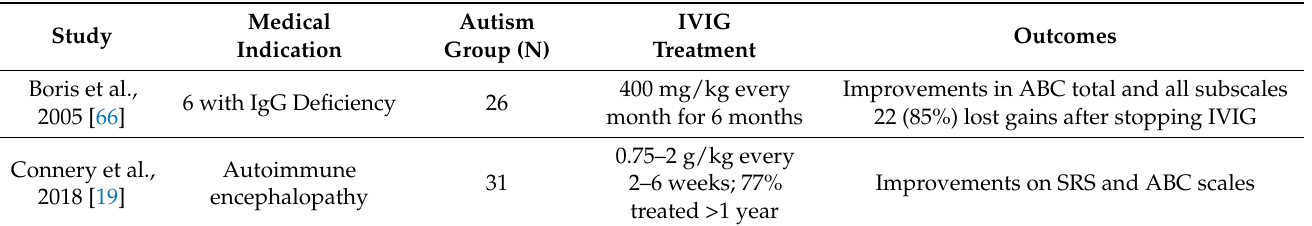
Table 5. Retrospective Case Series Immunoglobulin G Treatment Studies in Autism Spectrum Disorder with Prospectively Baseline Controlled Outcome Measures. Aberrant Behavior Checklist (ABC).